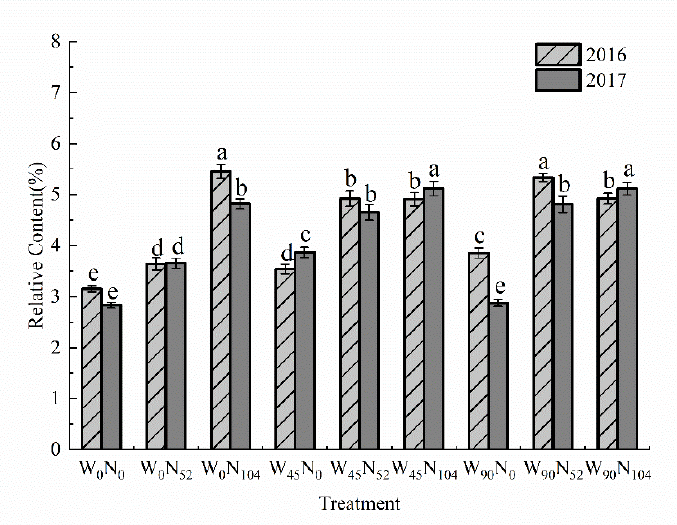
Figure 4. Effect of irrigation, nitrogen, and the interaction between the two on glutamic acid content of sunflower seed kernels (mean ± SD; different lowercase letters indicate that there are significant differences in nine treatments at the 5% level in 2016 and 2017,